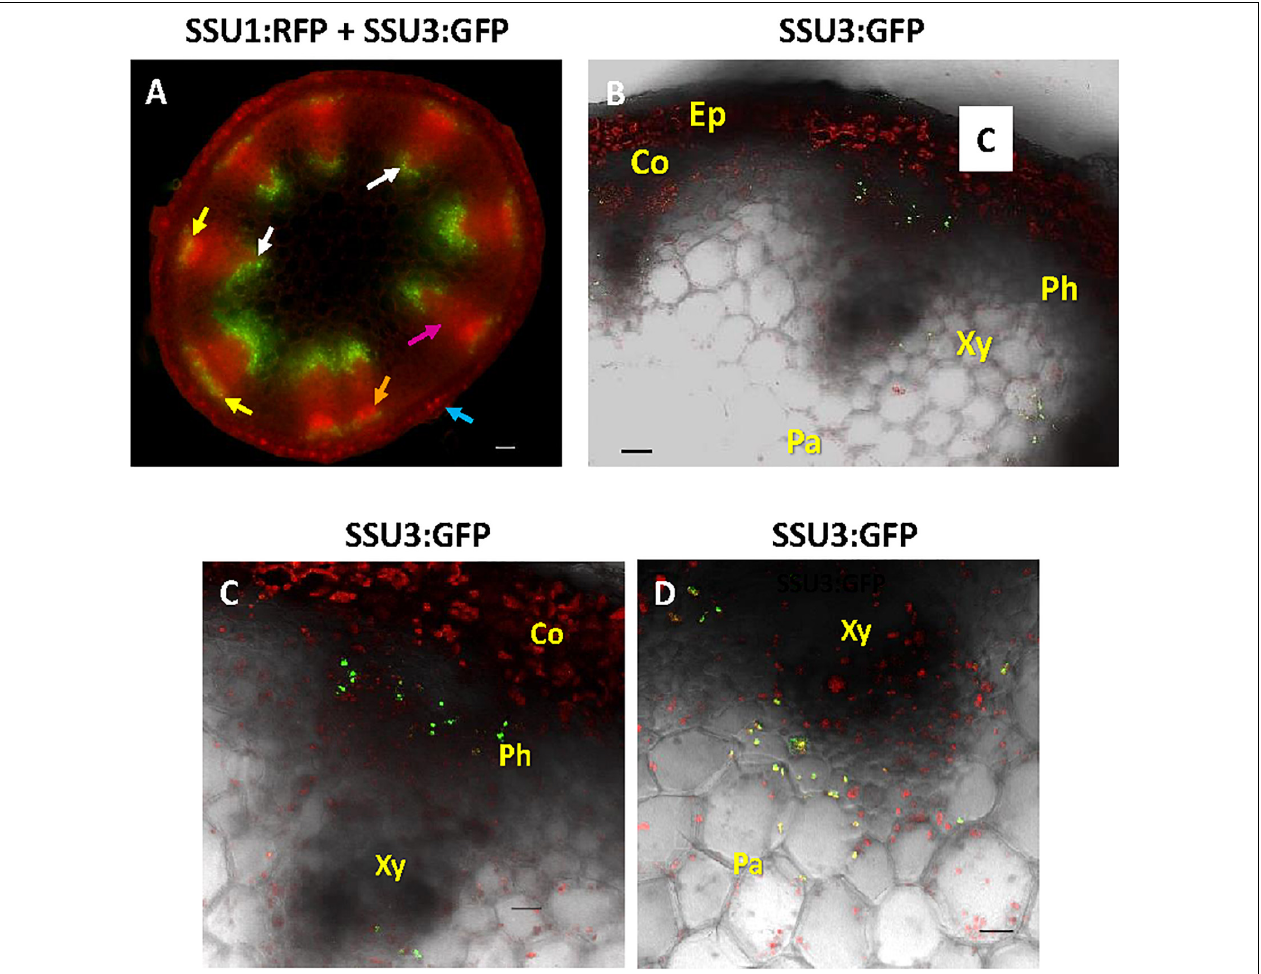
FIGURE 7 | Cross section through a flowering stalk. (A) In a dual reporter line, IPMI SSU3:GFP expression is seen in cells associated with the phloem (indicated by yellow arrows) but also in parenchyma cells proximal to the xylem (white arrows, with some background autofluorescence of lignin in the xylem), whereas IPMI SSU1 labeled with RFP lights up in the epidermis (blue arrow) and also in phloem-associated cells (orange arrow), although a clear resolution of the organelles is not possible in this image. Background red autofluorescence is exemplarily indicated by a purple arrow. (B–D) Magnified cross section shows IPMI SSU3:GFP co-expression in cells associated with the phloem (Ph) and the xylem (Xy). Other abbreviations: Co, cortex; Ep, epidermis. (C) IPMI SSU3:GFP in cells in close proximity to the phloem. (D) IPMI SSU3:GFP in cells located proximal to the xylem. Scale bars: 50 µ m (A) , 20 µ m (B–D) .